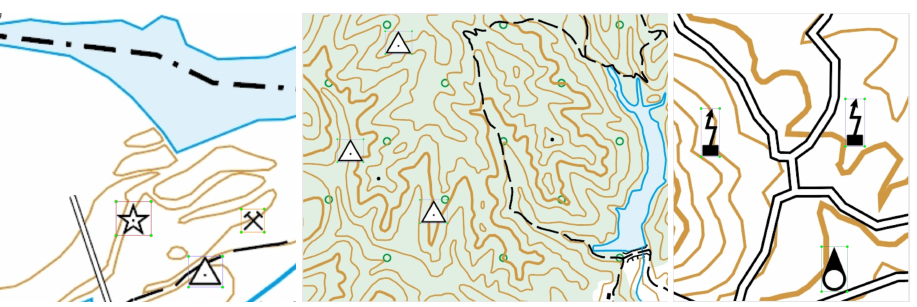
Figure 5. Three annotation samples of the vectorized map